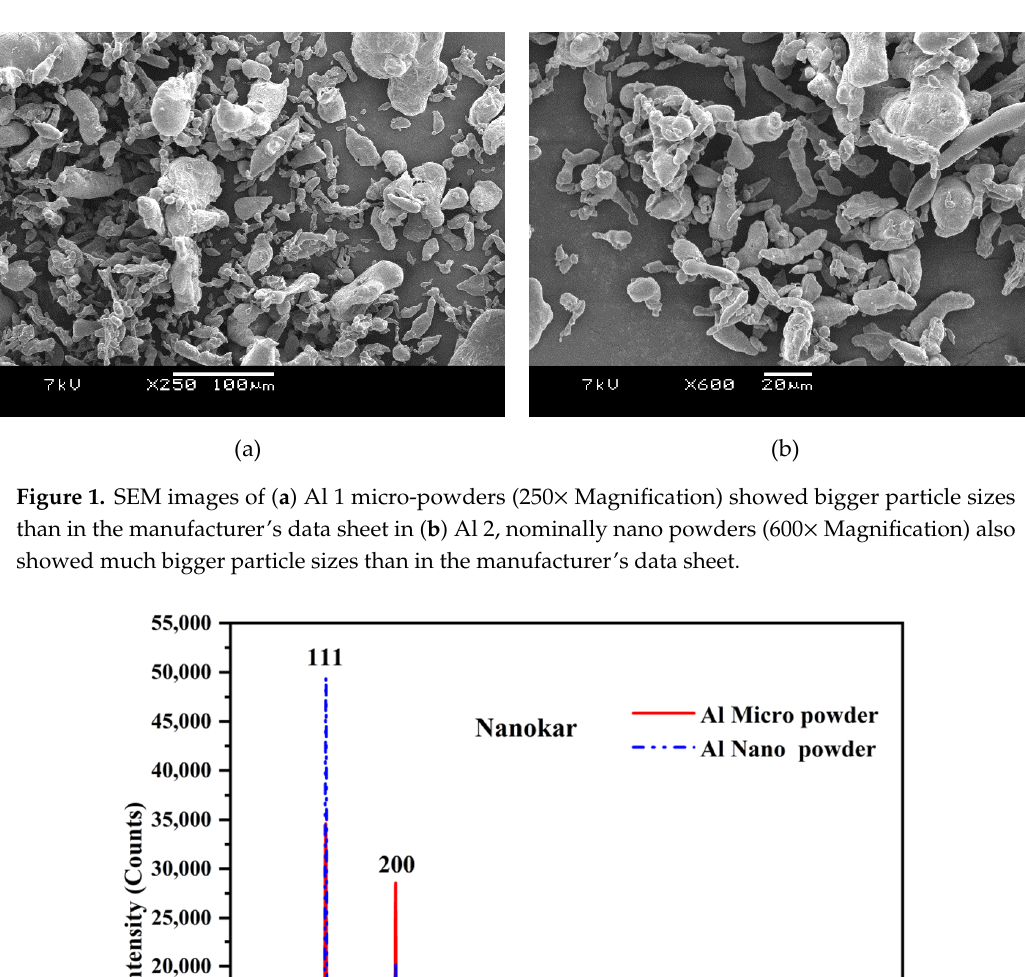
Figure 1. SEM images of ( a ) Al 1 micro-powders (250× Magnification) showed bigger particle sizes than in the manufacturer's data sheet in ( b ) Al 2, nominally nano powders (600× Magnification) also showed much bigger particle sizes than in the manufacturer’s data sheet.